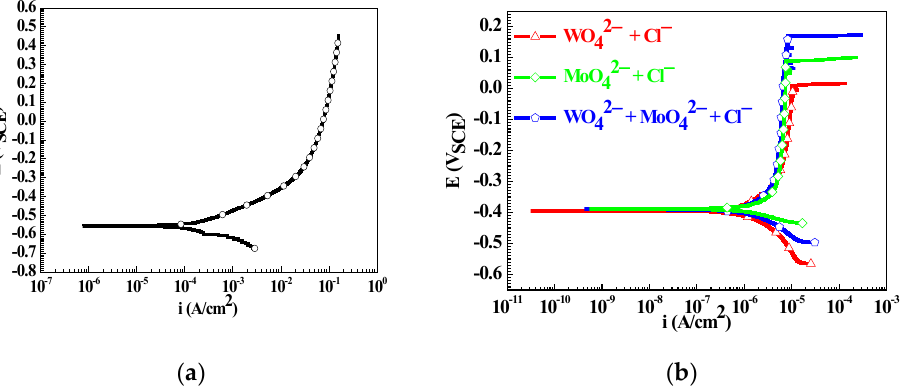
Figure 2. Polarization curve of the Q235 sample in 0.1 mM NaCl solution ( a ) and cyclic polarization curves of the Q235 samples in WO 4 2− + Cl − , MoO 4 2− + Cl − and WO 4 2− + MoO 4 2− + Cl − solutions ( b ).